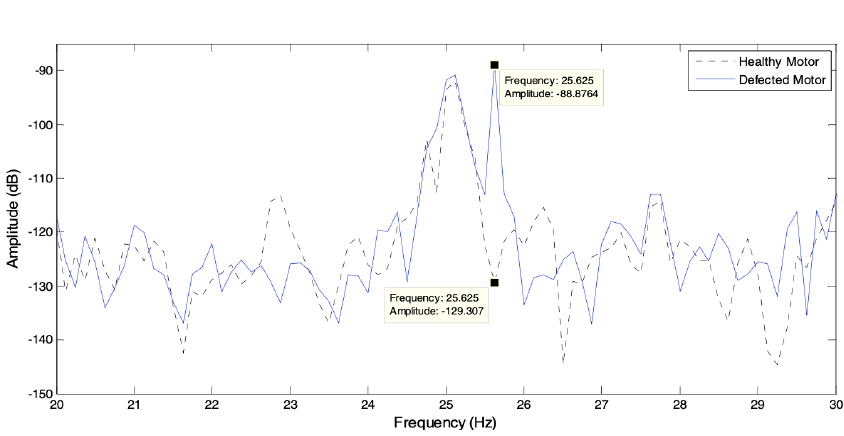
Figure 26. Localize analysis equation [104].